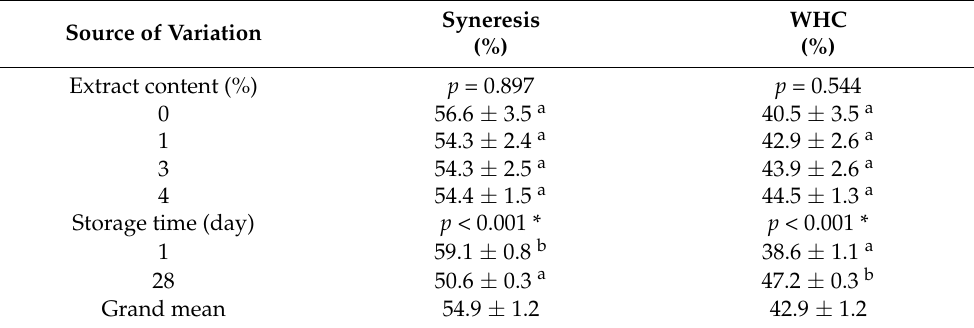
Table 6. Influence of extract content (0, 1, 3 or 4% ME) and storage time (1st and 28th day) on the syneresis and WHC of the produced